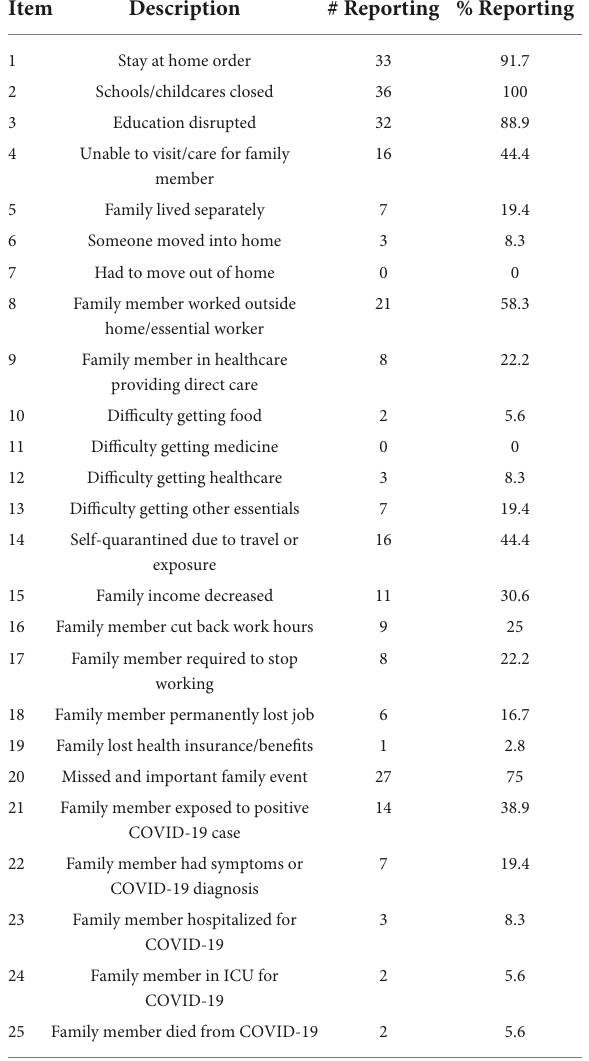
TABLE 1 CEFIS-Exposure scale items and